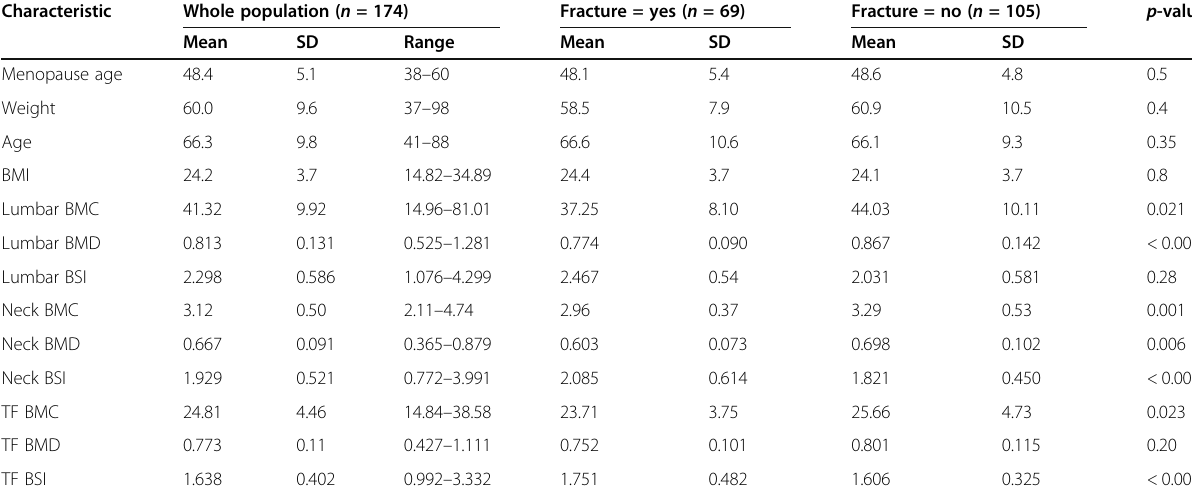
Table 1 Study population according to the two groups of patients (fractured versus non-fractured). p -values (last column) refers to the comparison between the group of patients in which a vertebral fracture occurred at follow-up (fracture = yes) and those who did not develop a vertebral fracture (fracture = no)